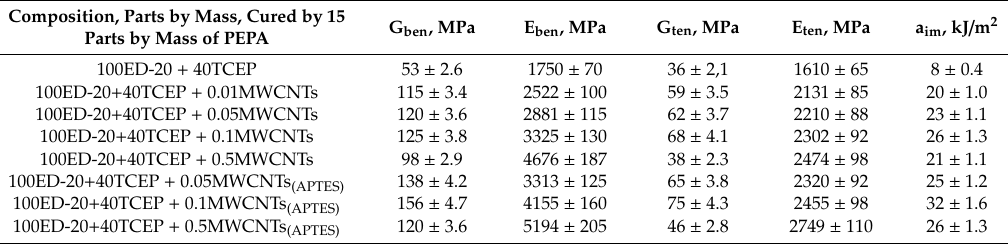
Table 5. Properties of epoxy composites.